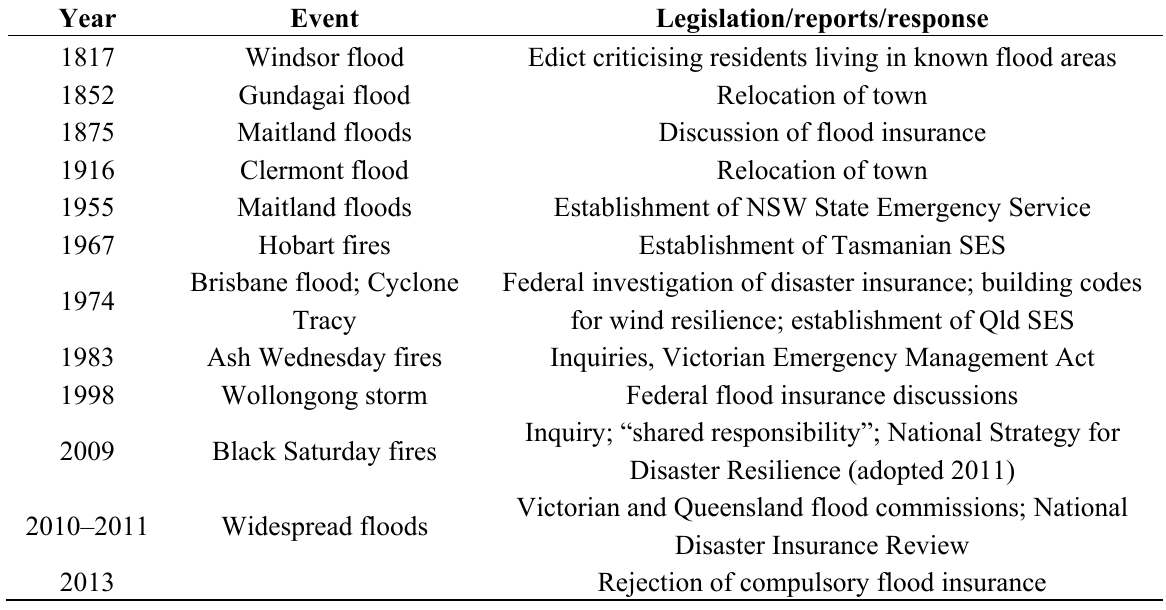
Table 1. Selected natural hazard events and resultant changes in disaster management in